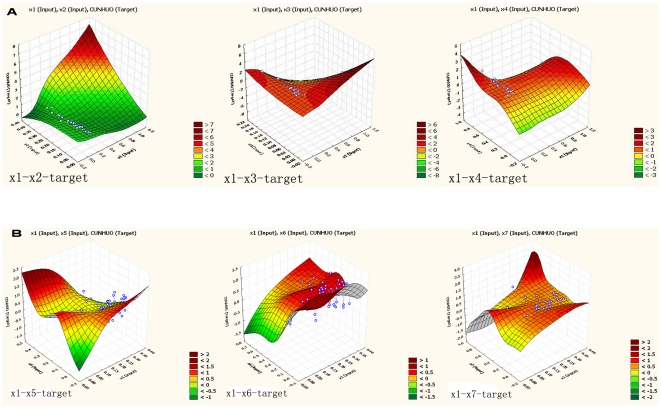
Curved surface diagram of outcome prediction in the MLP network (taking HB as an example).(2A): The one-year network. The x-axis represents input variable HB (x1), while the y-axis represents another variable: donor BMI (x2), TB (x3), or ALB (x4). The z-axis represents the output prognosis (ie., the MLP target). (2B): The two-year network. The x-axis represents HB (x1), and the y-axis represents another variable: Crea (x5), INR (x6), or Na+ (x7). The z-axis represents the output prognosis.